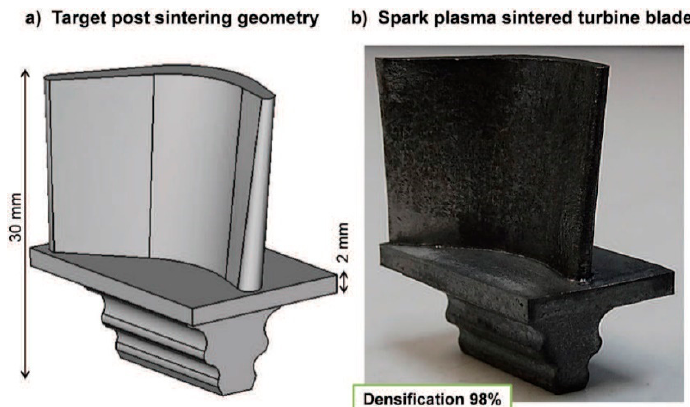
Figure 17. Example of turbine blade in CoNiCrAlY obtained by the deformed interfaces method. ( a ) Target shape. ( b ) Complex part obtained by SPS [97]. Reproduced with permission from Powder Technology , published by Elsevier, 2017.